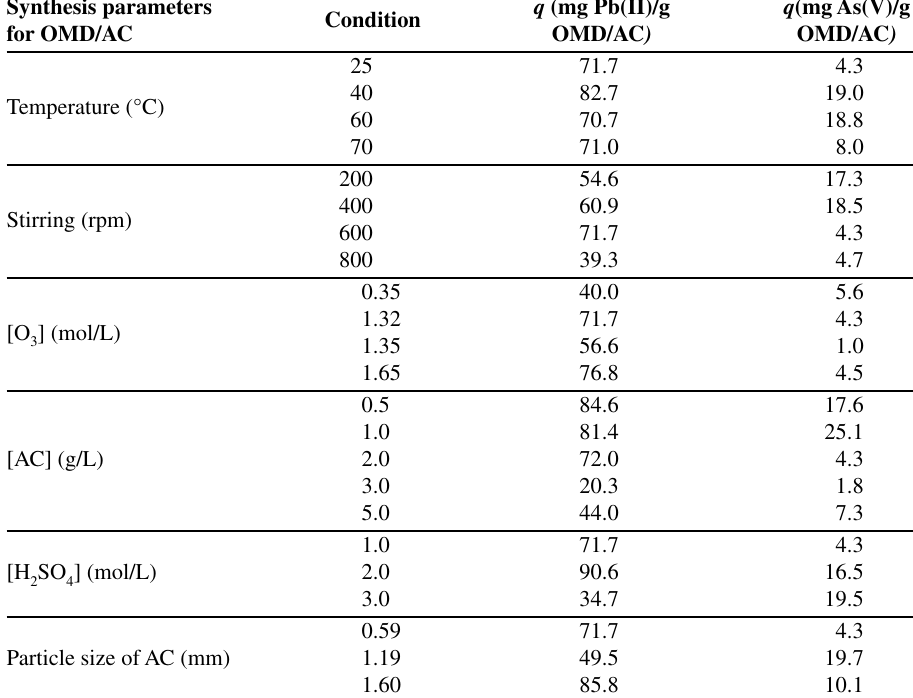
Table 4 . Adsorption capacities of OMD/AC for Pb(II) and As(V) with respect to different synthesis parame- ters for OMD/AC. Initial concentrations = 100 mg/L. Without OMD, q mg As(V)/g